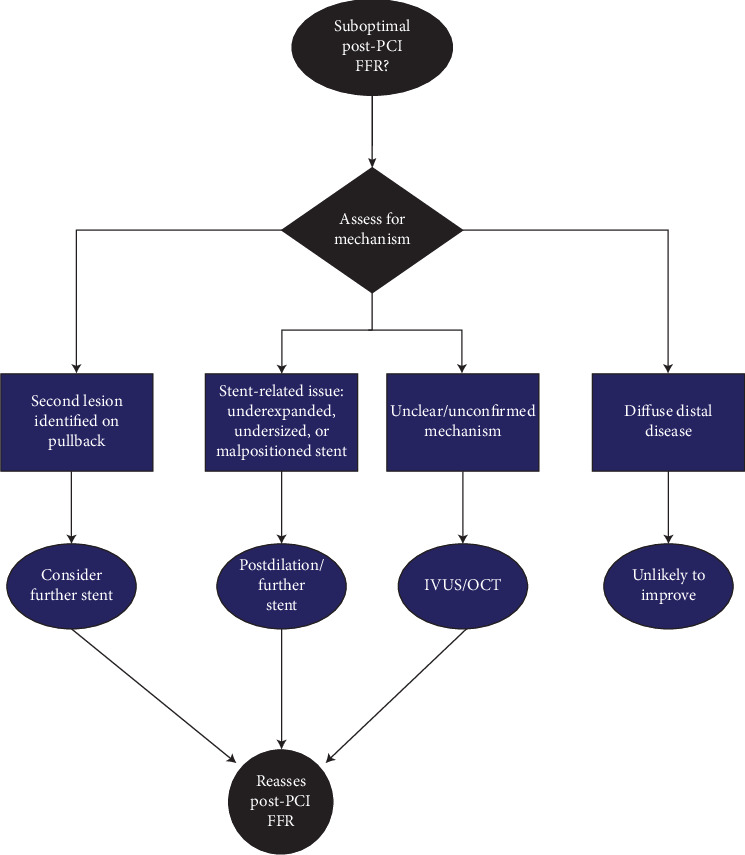
A simple schematic approach of interpretation of post-PCI FFR.